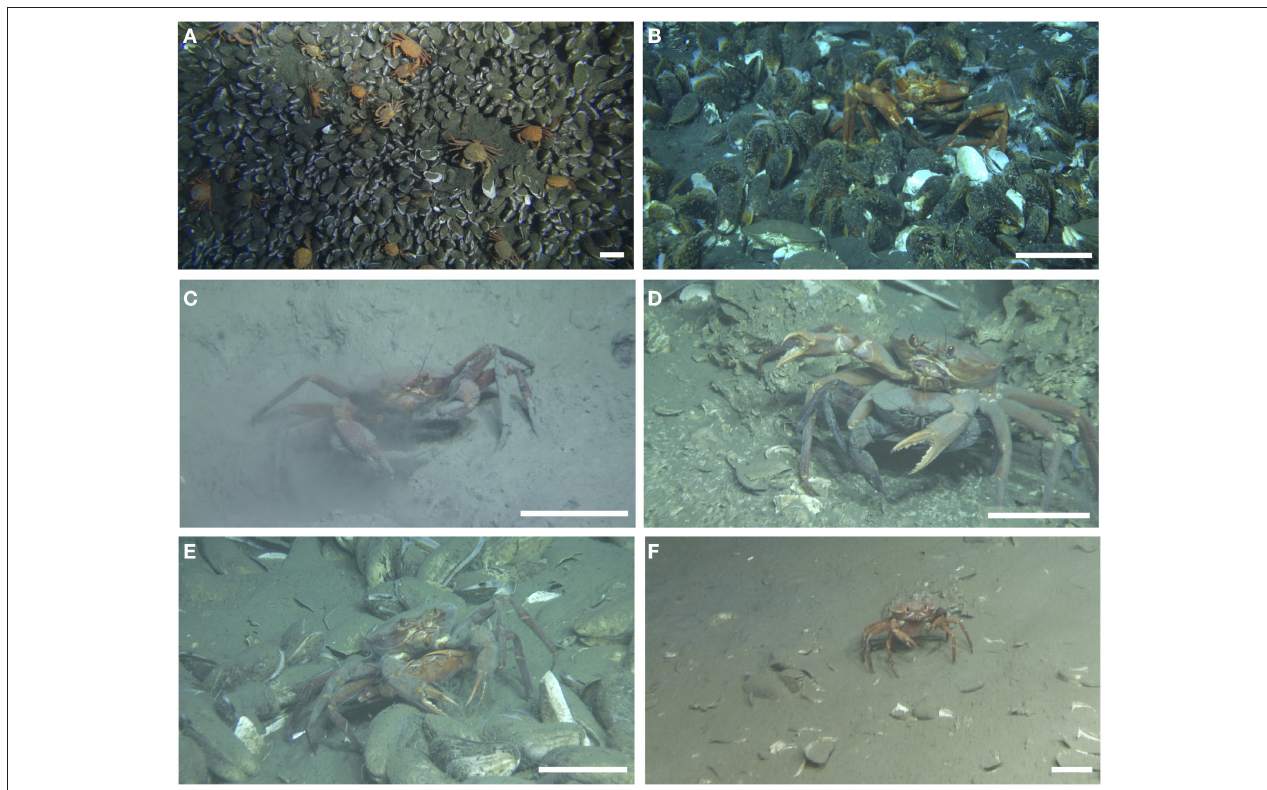
FIGURE 6 | Red crabs, Chaceon quinquedens. (A) Dense aggregations at Chincoteague East (Dive 4804). (B) Feeding on a bathymodiolin mussel at Baltimore (Dive 4808). (C) Sifting through sediment in an area of active methane bubbling at New England Seep 2 (Dive 4815). (D) Mating pair in precopulatory embrace at Chincoteague East (Dive 4806). (E) Mating pair in copulatory embrace at Chincoteague East (Dive 4806). (F) Ovigerous female at Chincoteague East (Dive 4806). Scale bars: ∼ 10cm.